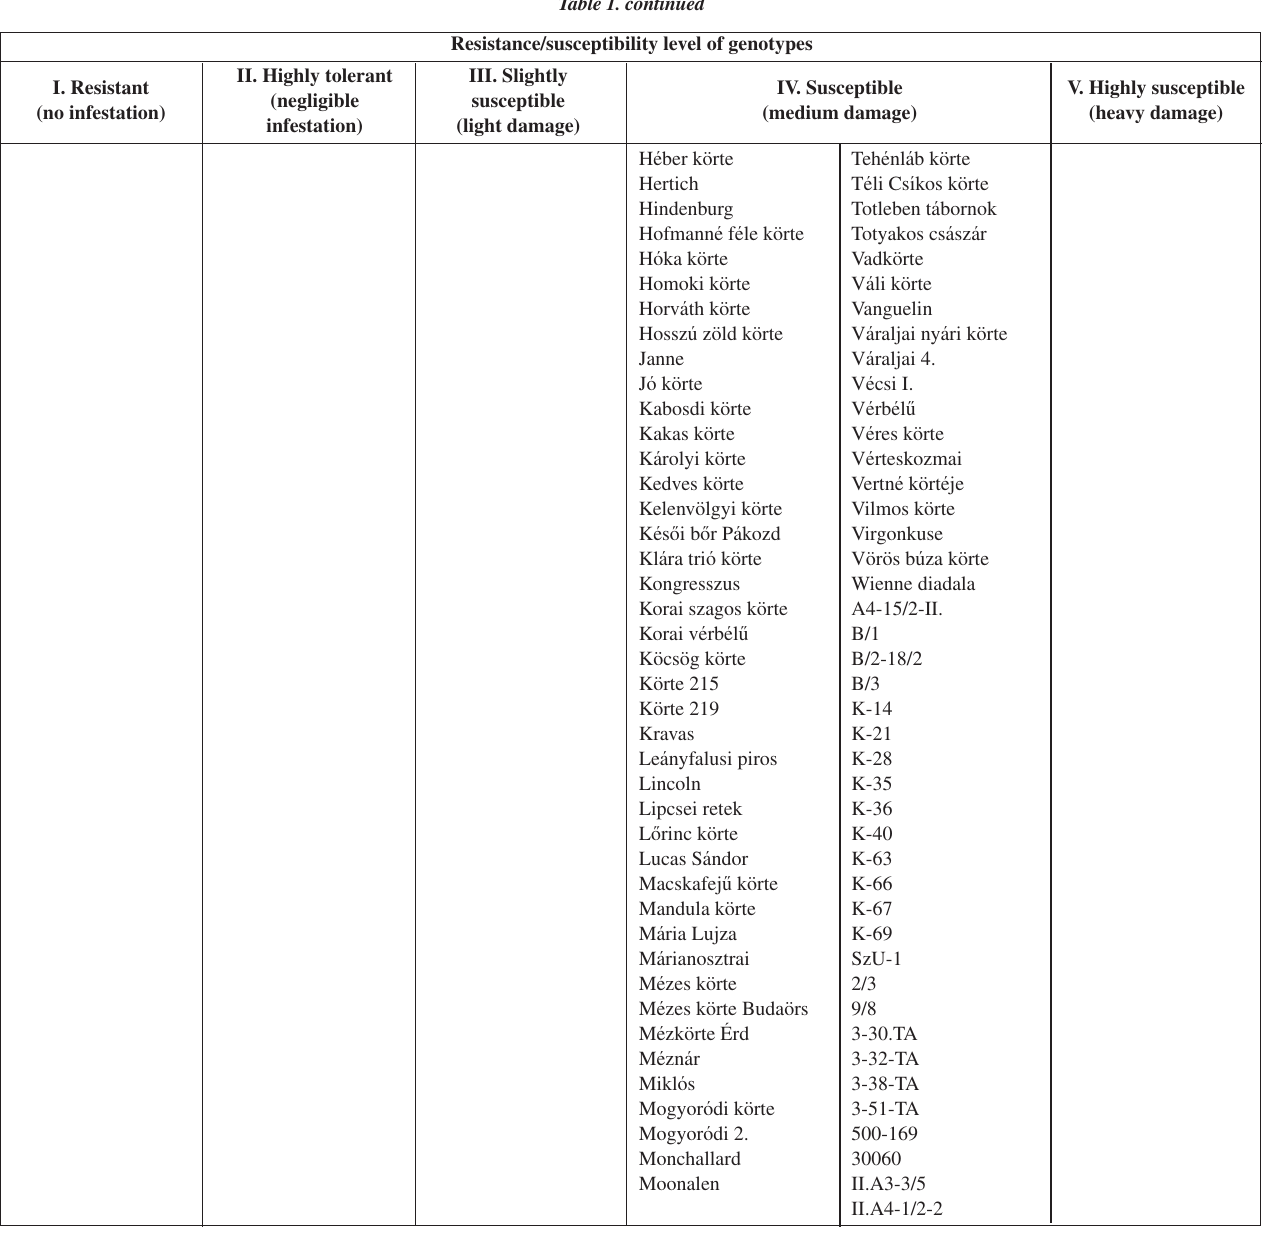
Table 2 . Distribution of pear genotypes (commercial cultivars, ancient local varieties, unnamed local strains, seedlings, wild seedlings) according to their susceptibility to pear psylla infestation and damage (Újfehértó gene bank: 1996–1999,